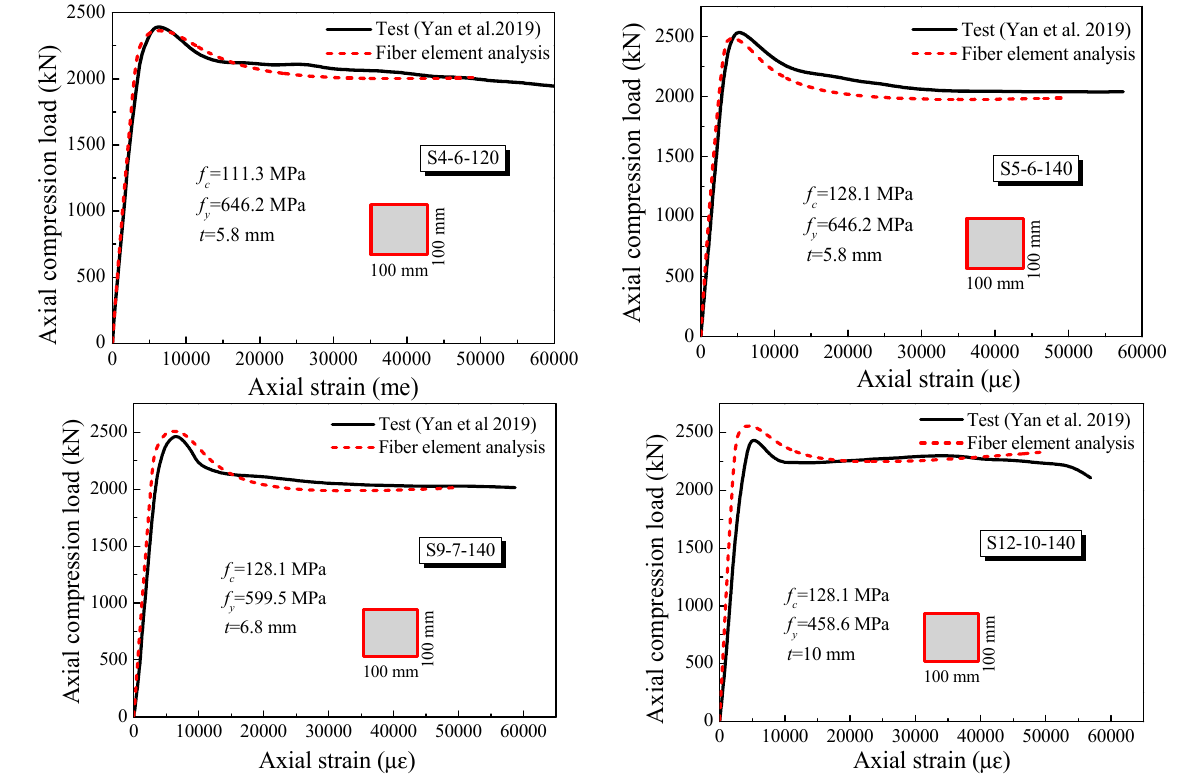
Figure 10. Calculations for the UHPCFST specimen column [30].